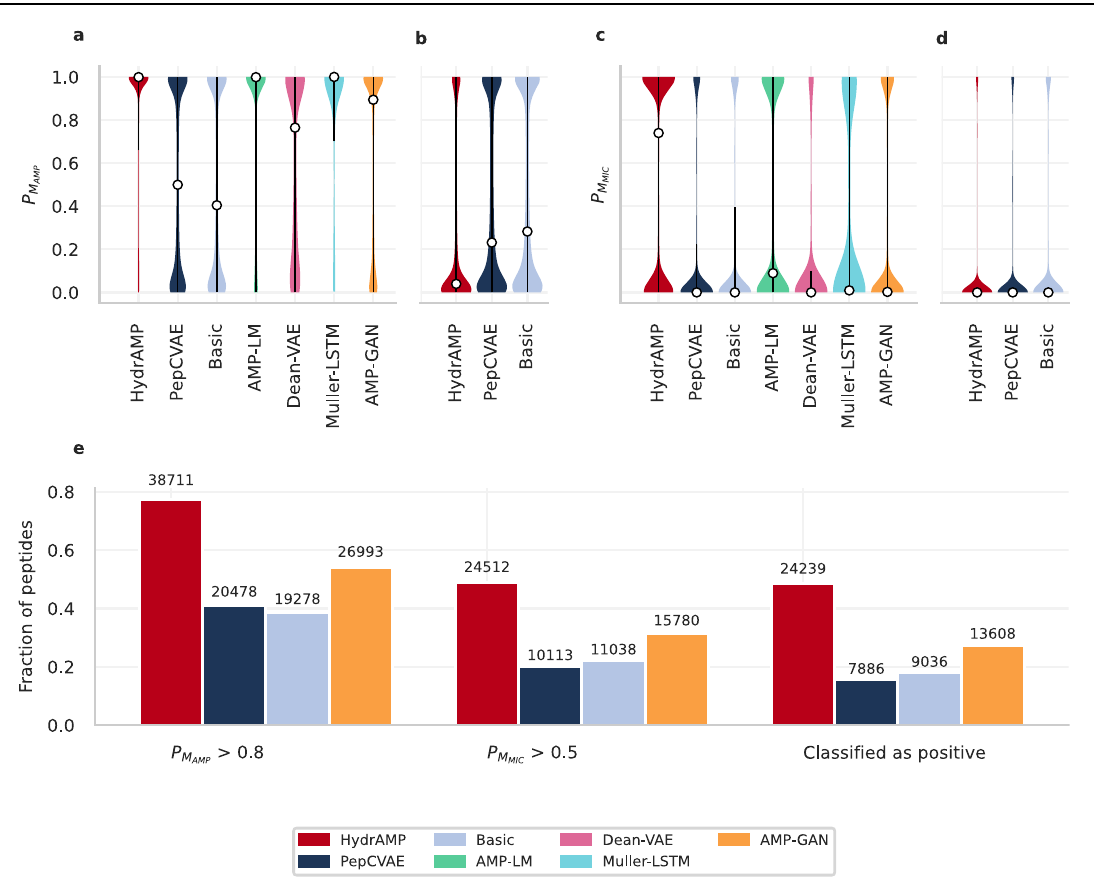
of each distribution. Sample sizes in panels a , c : HydrAMP n =50,000, PepCVAE n =50,000, Basic n =50,000, AMP-LM n =24,588, Dean-VAE n =2973, Muller- LSTM n =976, AMP-GAN n =50,000. Sample sizes in panels b , d : HydrAMP, PepCVAE and Basic n =50,000. e For the task of generating positive peptides, ), AMP >0 : 8 ( fi rst bar plot), fraction of peptides fraction of generated peptides with P M AMP with P M >0 : 5 (second bar plot), fraction of peptides that satisfy both previous MIC criteria i.e. classi fi ed as positive (third bar plot). The number over each bar: the actual number of peptides that met the condition. Source data are provided as a Source Data fi